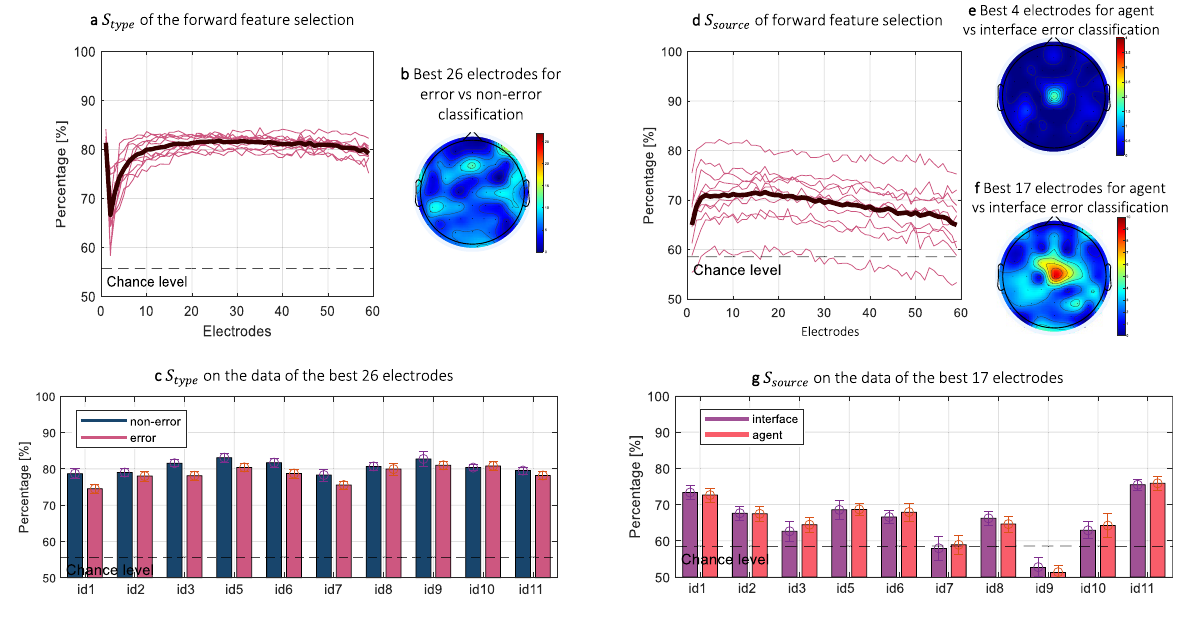
Figure 3. Electrode selection and the respective sensitivity: ( a ) the change of S type as the data from each of the additional electrodes was added to the classifier; ( b ) the distribution of the average of the best 26 electrodes; ( c ) the achieved S type non-error (dark blue) vs error (pink) for each subject on the data of the average best 26 electrodes; ( d ) the change of S source as the data from each of the additional electrodes was added to the classifier; ( e ) the distribution of the average of the best 4 electrodes that achieved the second-best average S source ; ( f ) the distribution of the best 17 electrodes that achieved the best average S source ; ( g ) the achieved S source for each subject on the data of the average best 17 electrodes, interface errors in purple, and agent errors in red.